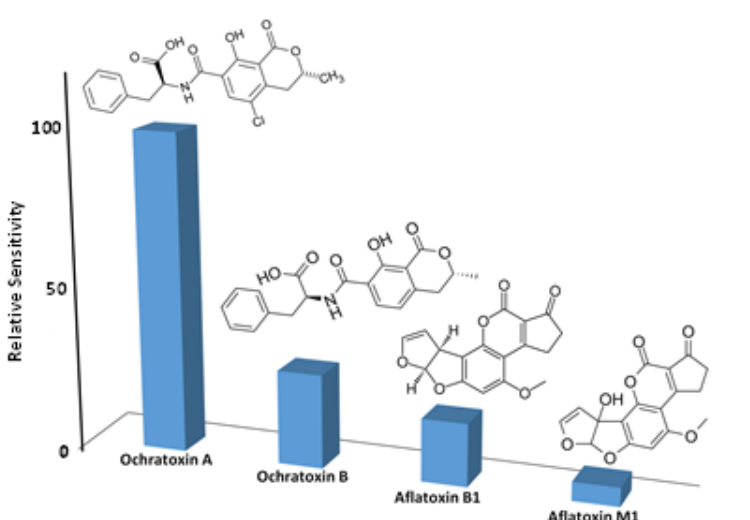
Figure 9. Sensitivity of the OTA sensor in the presence of Ochratoxin A, Ochratoxin B, Aflatoxin B1 and Aflatoxin M1.